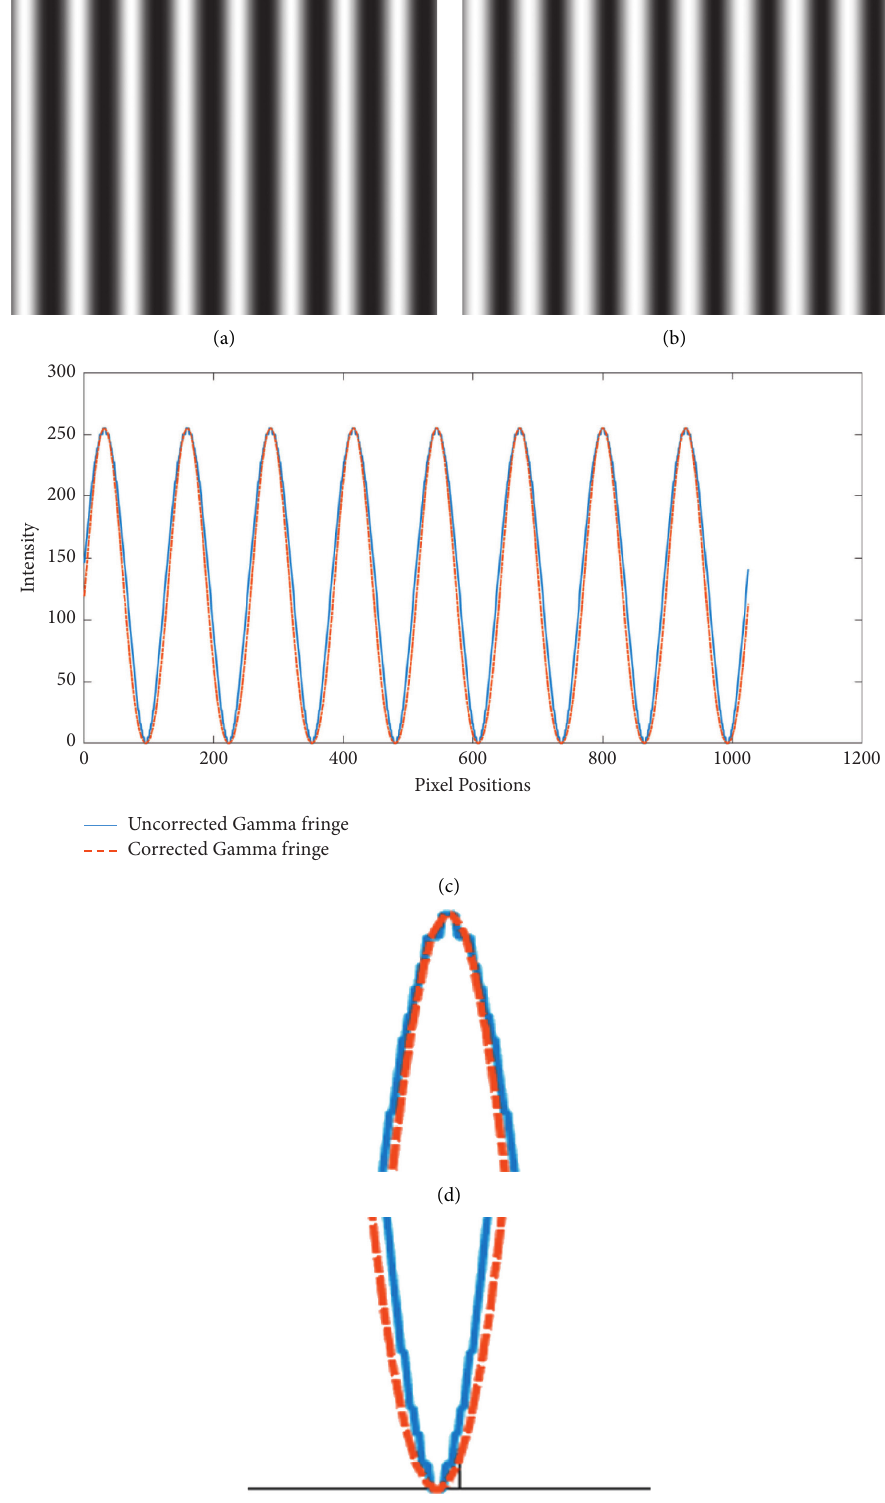
Figure 4: Simulation results. (a) Precoding fringe with gamma � 1.638. (b) Captured fringe simulation. (c) Sinusoidal contrast of fringe before and after correction. (d) Contrast of sine wave crest. (e) Contrast of sine wave